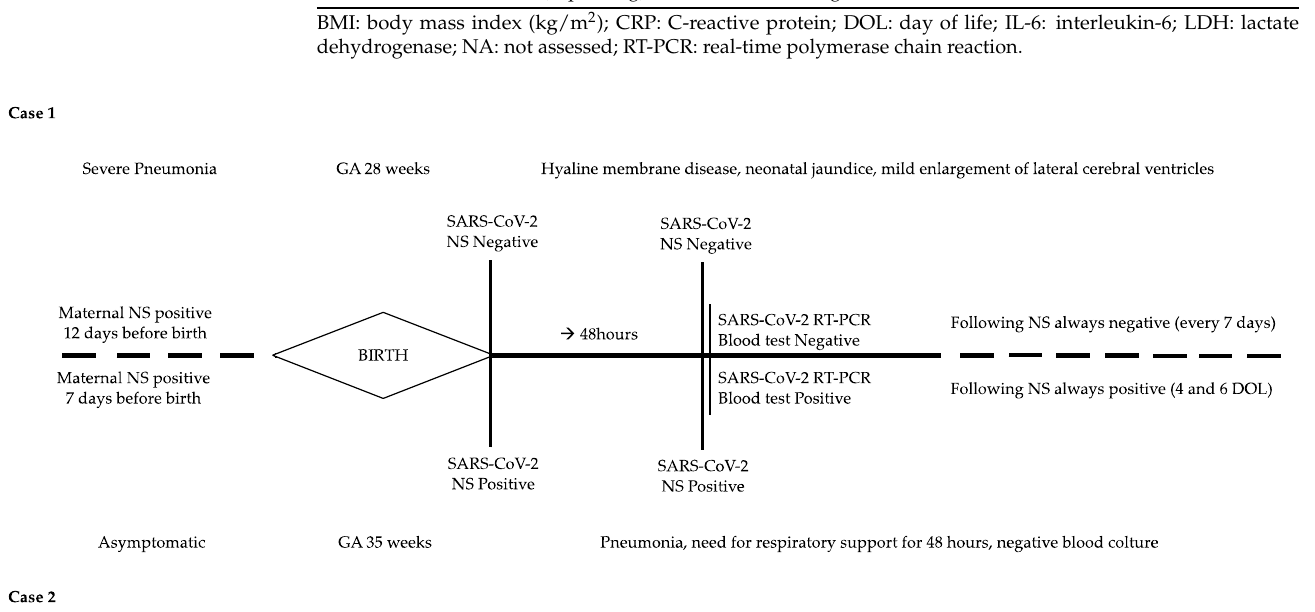
Figure 1. Timeline of clinical course and laboratory tests of the two cases. DOL: day of life; GA: gestational age; NS: nasopharyngeal